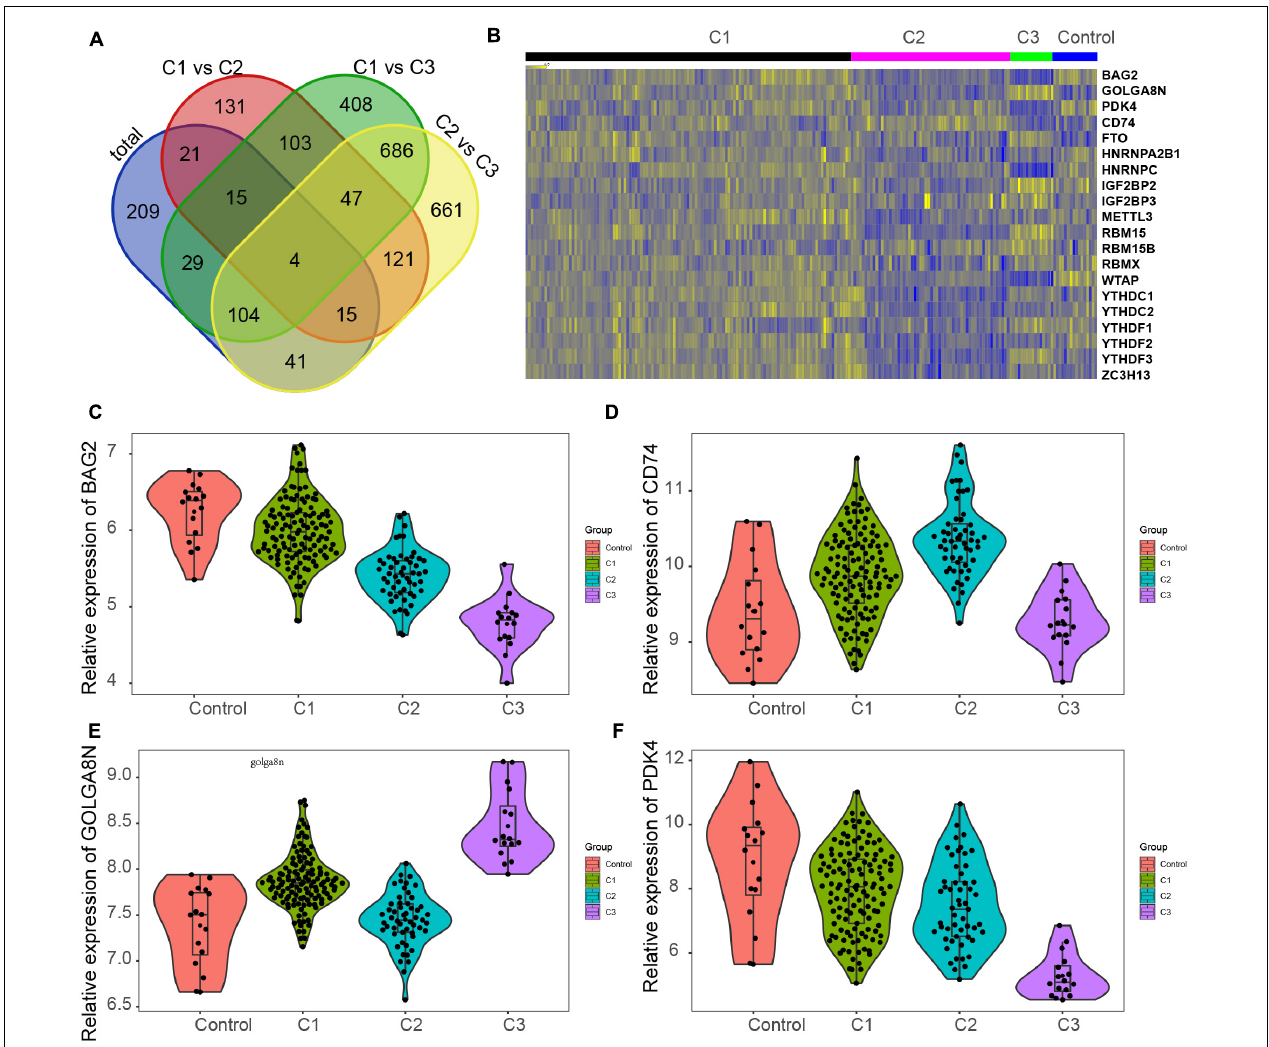
FIGURE 7 | Screening of key genes in different clusters of MI. (A) Venn diagram showed four common DEGs among all clusters in MI, including BAG2, CD74, GOLGA8N, and PDK4. (B) Heatmap showed BAG2, CD74, GOLGA8N, and PDK4 expression among all clusters in MI. (C–F) BAG2 (C) , CD74 (D) , GOLGA8N (E) , and PDK4 (F) were differently expressed among all clusters in